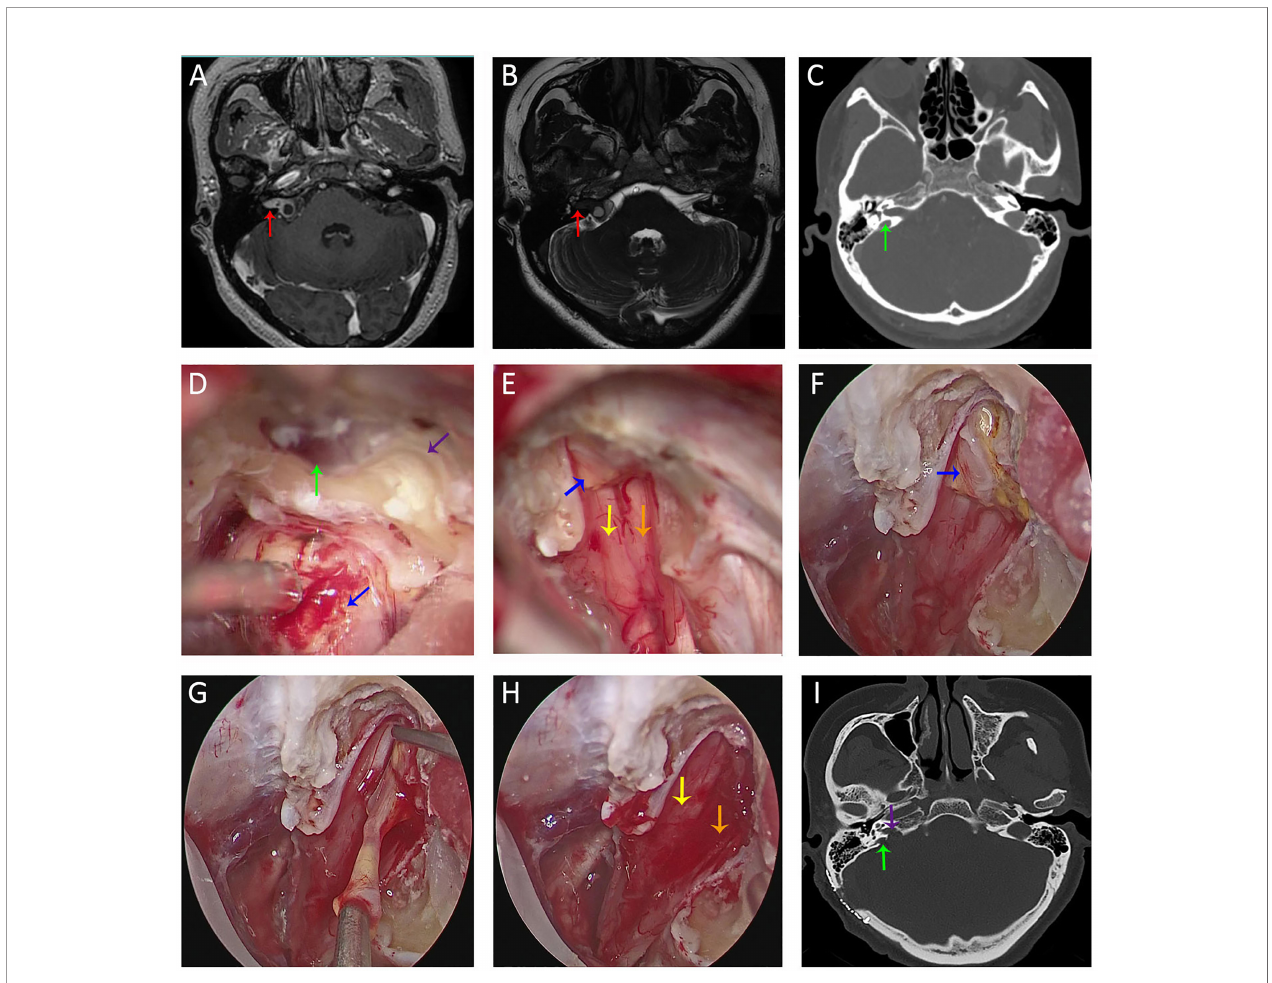
FIGURE 4 | Imaging studies and intra-operative snapshots of a vestibular schwannoma patient with tumor extending into the IAC and a high-riding jugular bulb. (A, B) Pre-operative T1WI with contrast (A) and FIESTA-C (B) indicated a right-sided vestibular schwannoma extending into the IAC [red arrow in (A) ]. The fundus of IAC was occupied by the tumor without CSF signal as indicated by the red arrow in (B) . (C) Pre-operative CT imaging revealed a right-sided high-riding jugular bulb (green arrow); (D) After debulking of the tumor at the porus acusticus (blue arrow), the posterior IAC was drilled (purple arrow) and skeletonization of the bone matter adjacent to the jugular bulb was performed. (E) After transposition of the jugular bulb, the posterior IAC was further drilled. After tumor removal under microscopic view, there were still tumor remnants (blue arrow) at the fundus of IAC. CN VII (yellow arrow) and CN VIII (orange arrow) were anatomically preserved. (F) With neuroendoscope, tumor remnants (blue arrow) were better visualized and delineated. (G) Tumor resection between two arachnoid layers under direct endoscopic view. (H) CN VII (yellow arrow) and CN VIII (orange arrow) were anatomically preserved after total removal of the tumor under endoscopic view. (I) Post-operative CT revealed opening (purple arrow) of the posterior IAC and medial wall of the bone matter (green arrow) adjacent to the jugular bulb. FIESTA-C, heavily T2-weighted fast imaging employing steady-state acquisition with cycle phase; T1WI, T1 weighted